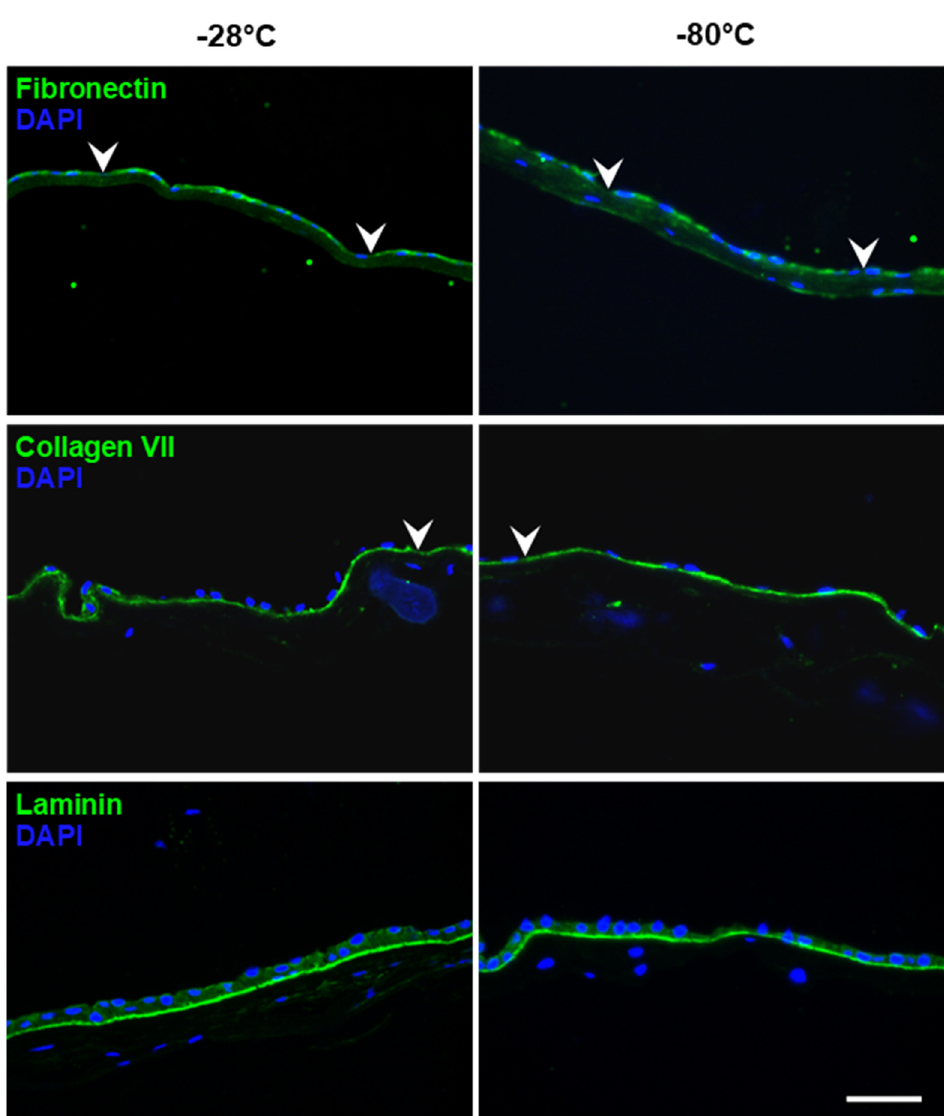
Figure 2. Representative immunohistochemical stains of basement membrane proteins (green) after storage at -28 °C and -80 °C, respectively. Arrowheads: Disruption of staining/basement membrane. DAPI: 4 ′ ,6-diamidino-2-phenylindole (nuclear counterstain). Scale bar: 50 µm.